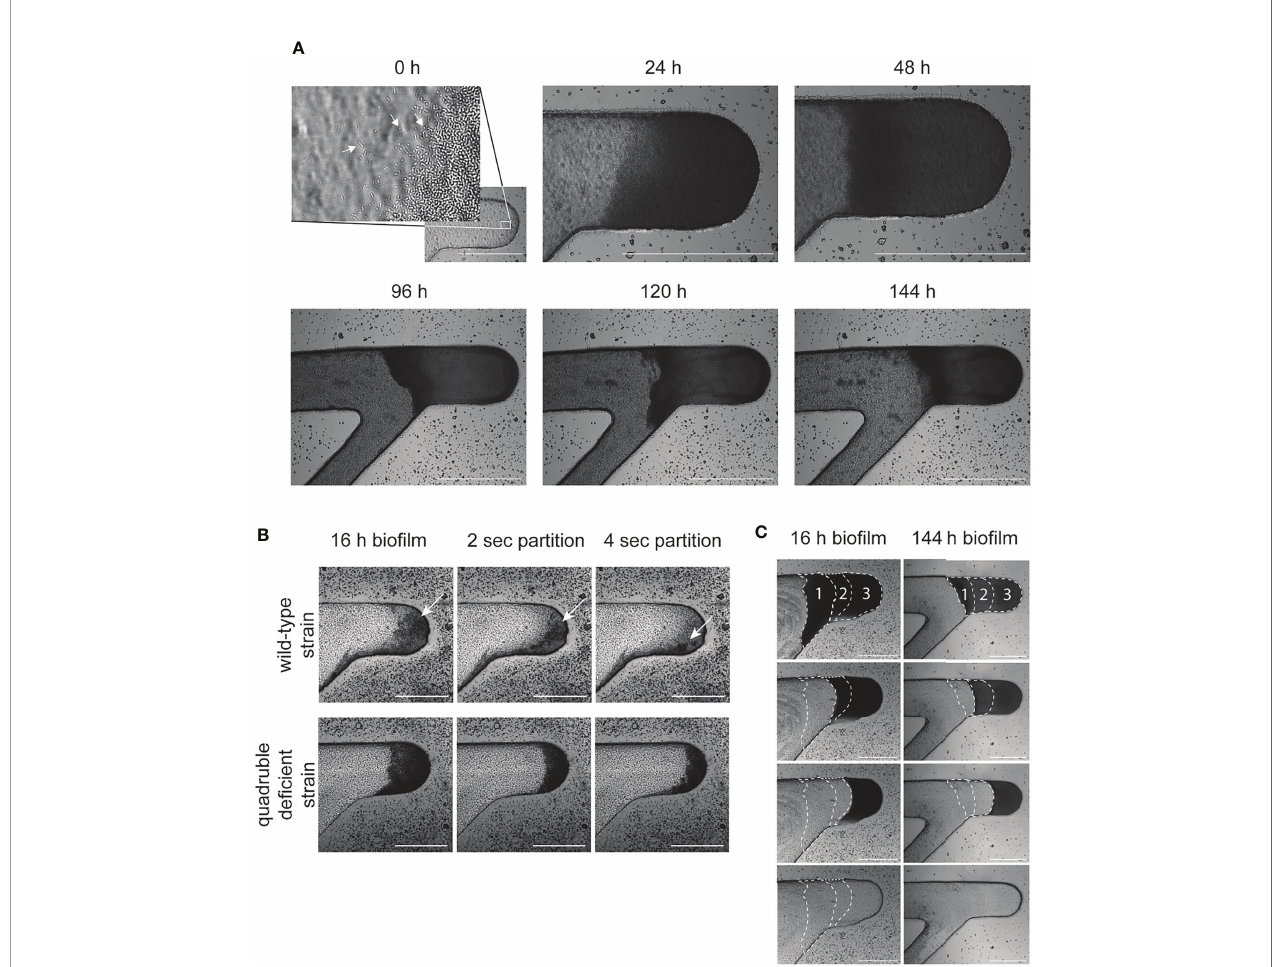
FIGURE 3 | Formation of E. coli MG1655 bio fi lms. (A) Formation of bio fi lm over 6 days in the micro fl uidic chip. Directly after seeding (0 h) individual pelleted cells were observed at the bottom of the growth chamber. White arrows indicate single and actively dividing seeded cells. (B) The integrity of 16 h cultures were evaluated to determine bio fi lm formation. Bio fi lm formation by wild-type E. coli (MG1655) was compared to an isogenic quadruple de fi cient strain lacking the entire genetic pathway for cellulose, curli, colonic acid and fi mbriae synthesis. (C) The micro fl uidic chip enabled strati fi cation and harvesting of bio fi lms, examples of controlled removal of bio fi lms grown for 16 h or 6 days are shown. Bio fi lms were divided into three sections (indicated by white dotted lines) and strati fi ed in sequential sequence (see Materials and Methods ). All scale bars represent 500